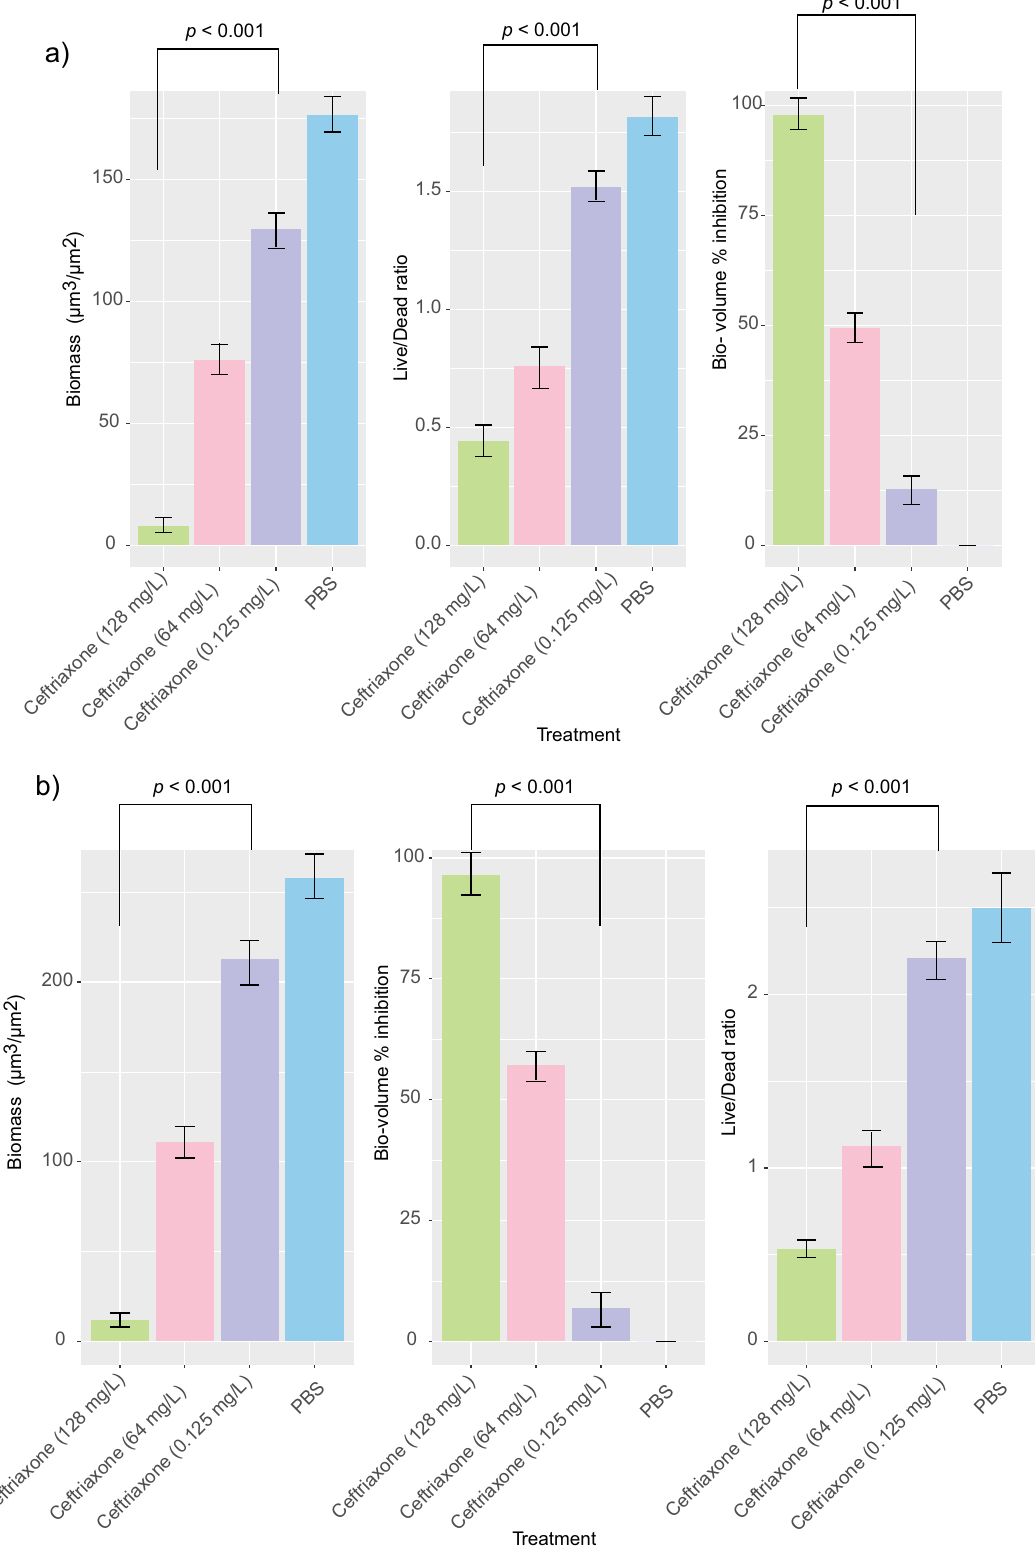
Figure 7. Effects of different concentration of ceftriaxone on N. gonorrhoeae isolates (n = 2). Isolate NG-083; ( a ) in vitro biomass ( b ) in vitro Live/Dead cell ratio ( c ) in vitro bio-volume inhibition and isolate NG-091; ( d ) in vitro biomass ( e ) in vitro bio-volume inhibition ( f ) in vitro Live/Dead cell